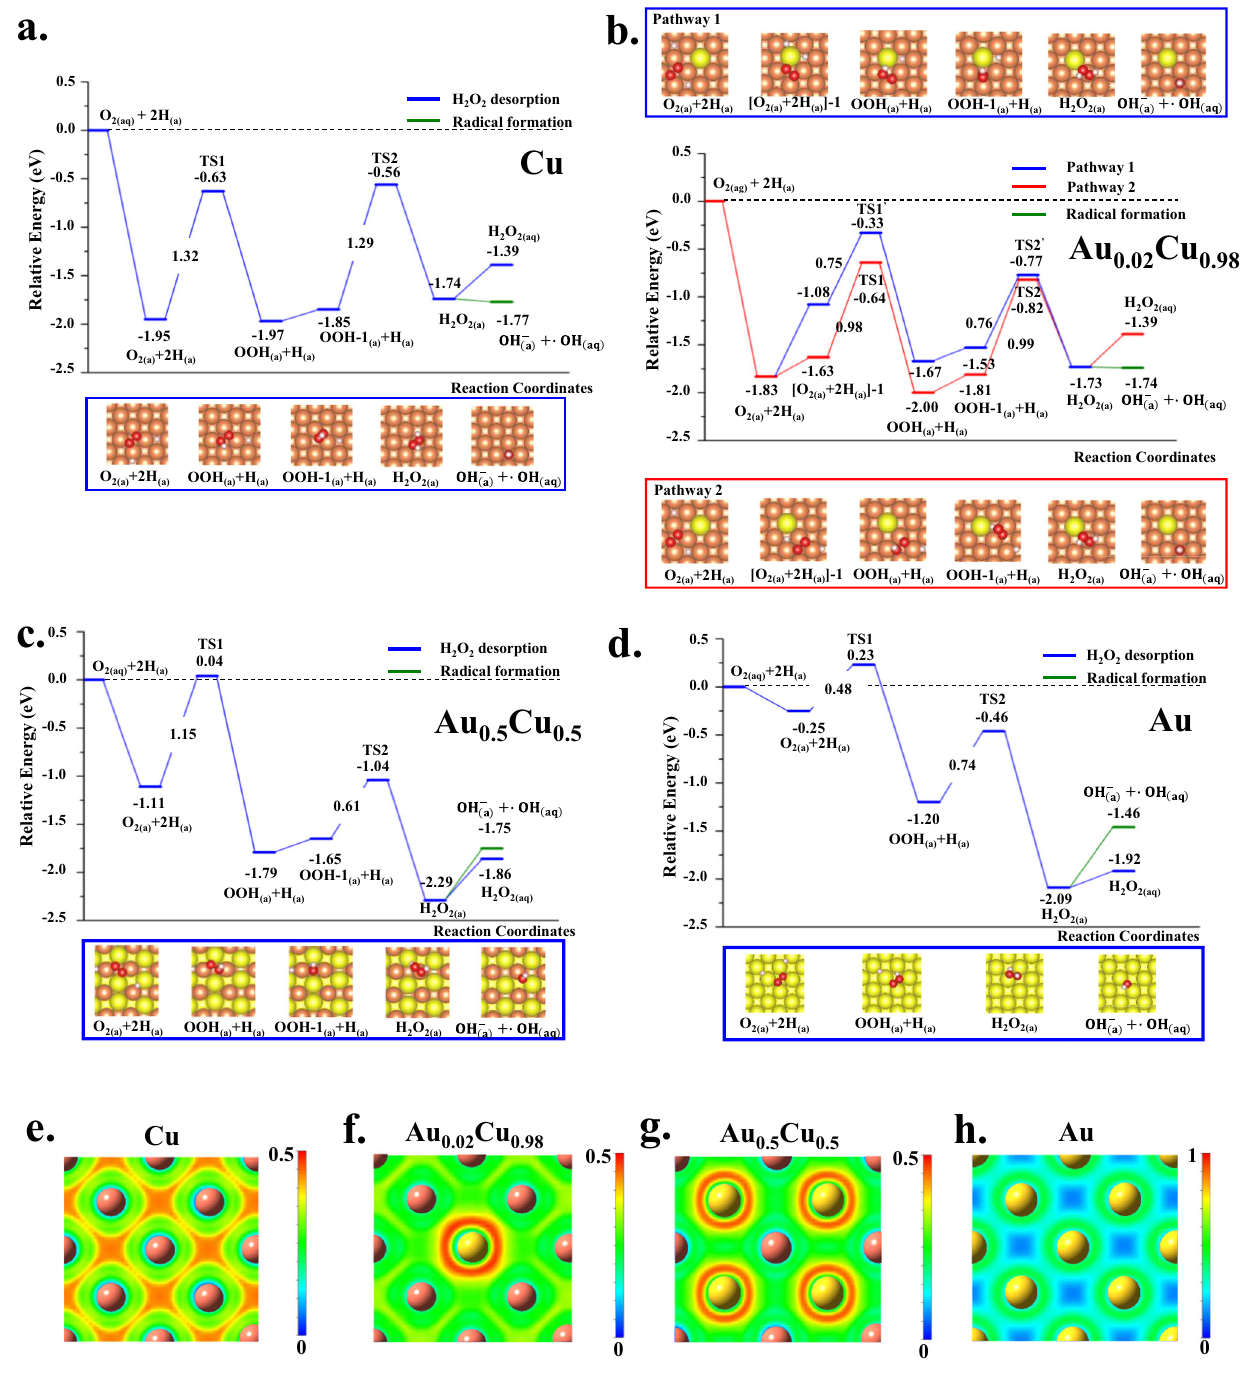
Fig. 4 | Simulation analysis in Cu, Au, and different Au/CuO. The calculated potential energy pro fi les for the O 2 reduction to H 2 O 2 on the a pure Cu, b Au 0.02 Cu 0.98 , c Au 0.5 Cu 0.5 , and d pure Au. The calculated electron